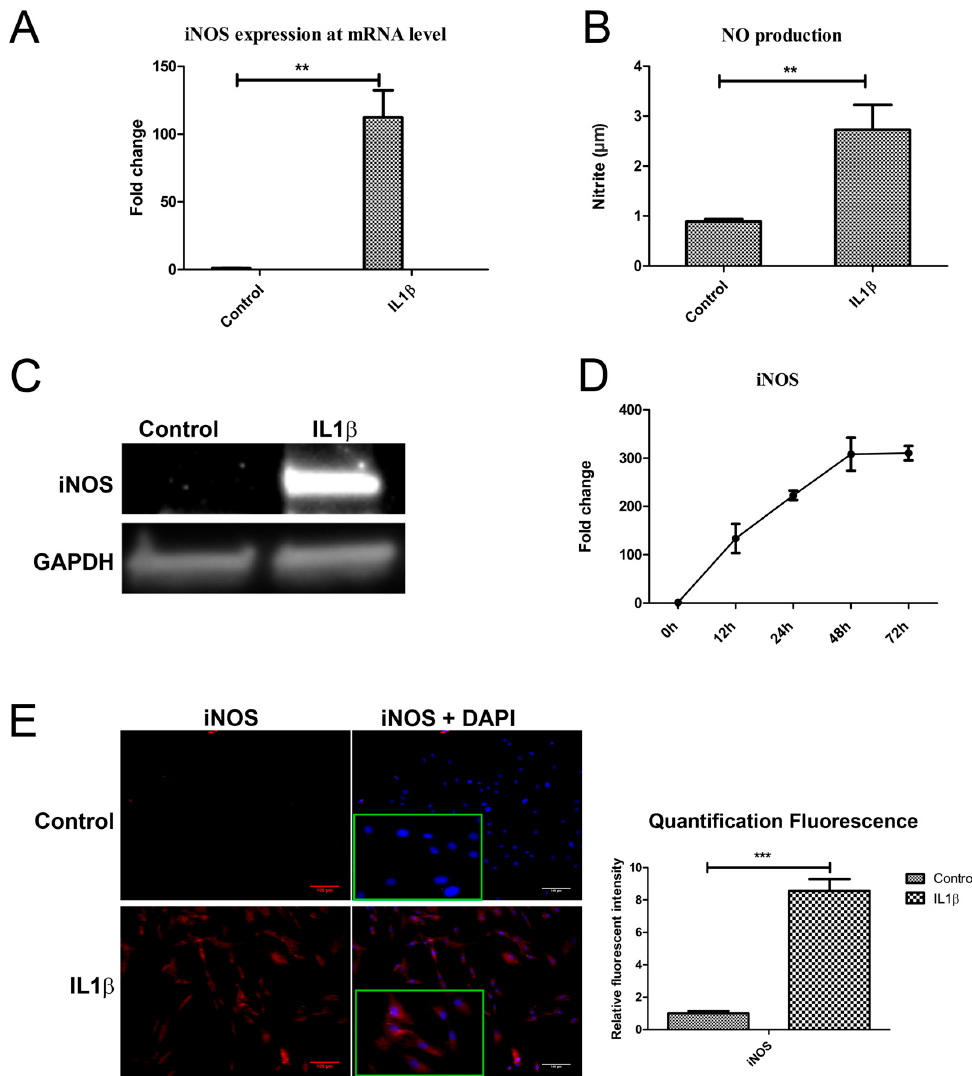
Figure 4. IL1 β induced iNOS expression at both mRNA and protein level. ( A , B ) Human chondrocytes were treated with IL1 β for 24 h. iNOS mRNA expression was detected by qPCR and nitric oxide (NO) production was measured by Griess assay. ( C ) Western blot was used detect iNOS protein expression. ( D ) Time course evaluation of iNOS mRNA expression after IL1 β treatment. ( E ) IF was used to measure iNOS expression, magnified pictures were indicated in inserts. Scale bars 100 μ m. Quantification of immunofluorescence intensity was performed by CellProfiler software. * p < 0.05, ** p < 0.01: significant correlation.